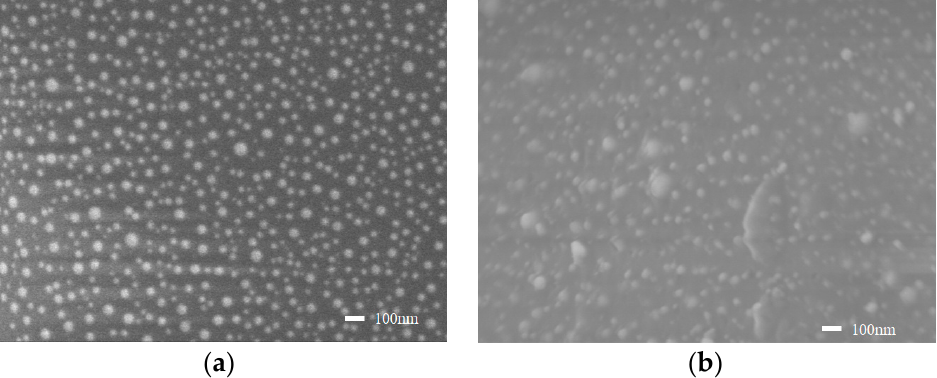
Figure 3. SEM micrographs of ( a ) Au-nanoparticle-coated optical fiber and ( b ) four layers of chitosan-gel-coated optical fiber.